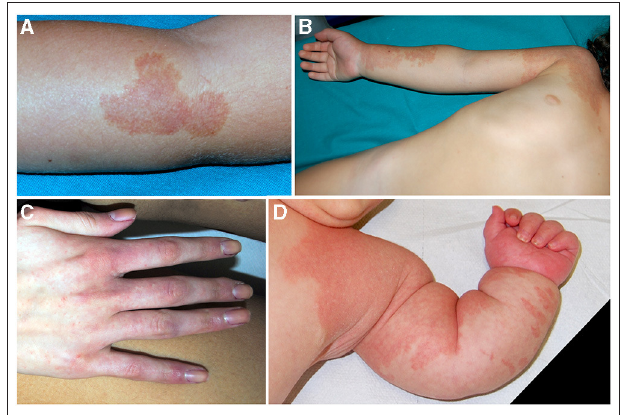
FIGURE 3 | Polycyclic vascular patch characterized by an anemic halo in a patient with CM-AVM (A) . Pink-red slightly pigmented capillary malformation (CM) of the right upper limb (B) . Pinpoint confluent telangiectasias in a patient with EPHB4 mutation (C) . Eight-month-old infant affected with Parkes–Weber syndrome with multiple CM and progressive overgrowth of the upper limb (D)